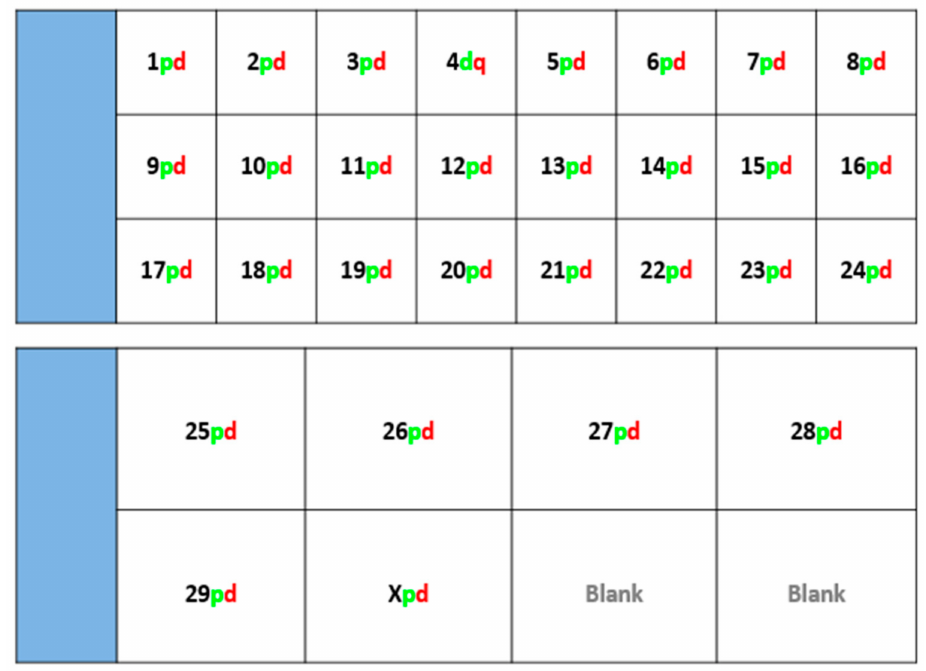
Figure 1. Schematic demonstrating the layout of probes designed to map to each bovine chromosome-selected from the most proximal (p) and most distal region (d) of each individual